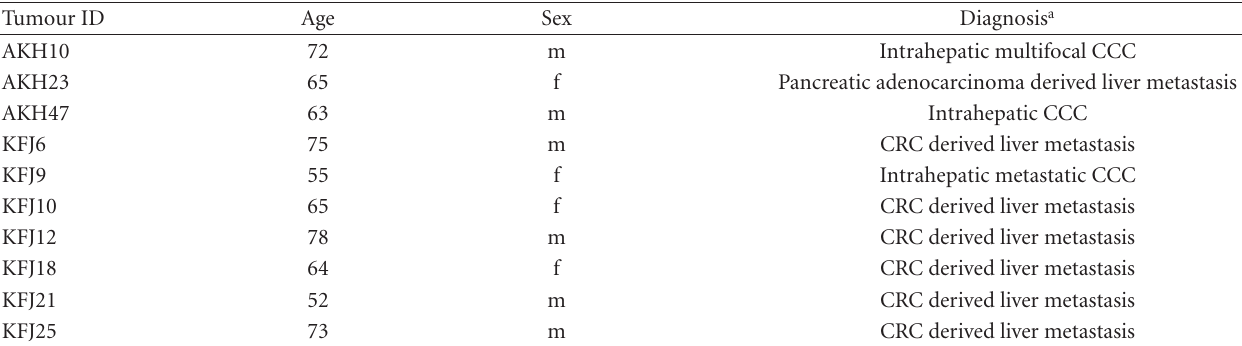
Table 2: Relevant characteristics of original human tumour